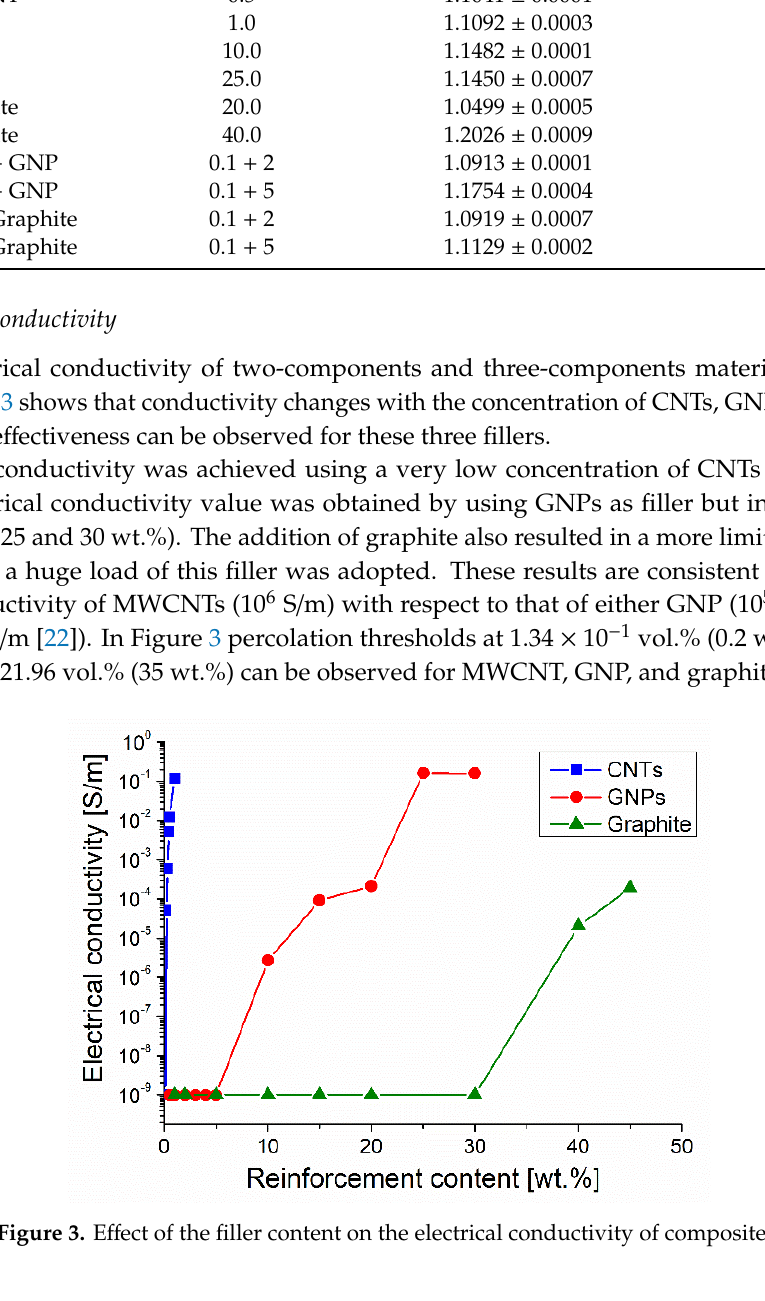
Table 2. Density of composites with different filler content.